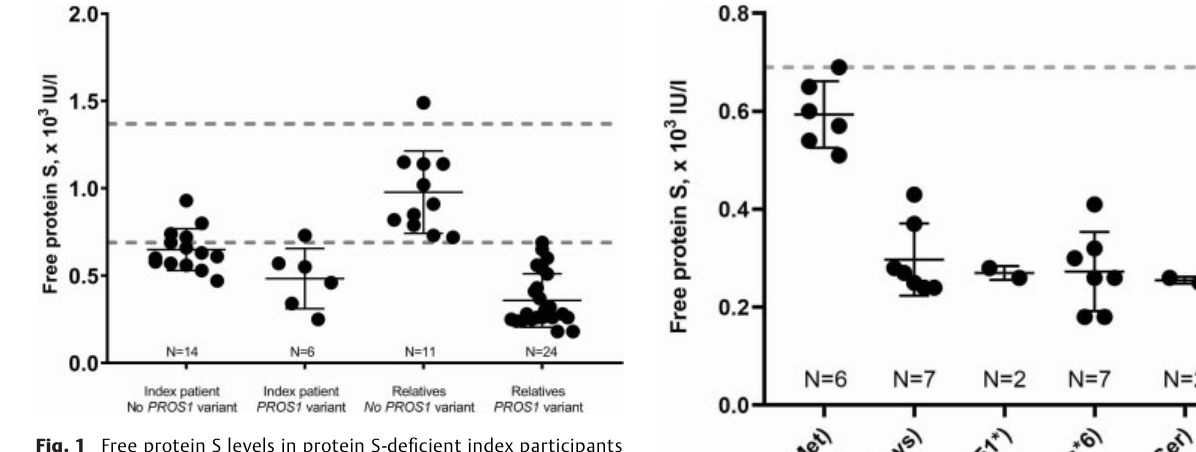
Fig. 1 Free protein S levels in protein S-de fi cient index participants witha PROS1 variantor withnormal PROS1 sequenceand relatives with PROS1 variant or normal PROS1 sequence. PROS1 variants included were: p.(Glu67Ala), p.(Thr78Met), p.(Gln305 (cid:4) ), p.(Thr331Ile), p. (Met385Val), p.(Glu390Lys), p.(Arg451 (cid:4) ), p.(Ile490Leufs (cid:4) 6), p. (Ser501Pro), p.(Leu526Ser). The reference interval for free protein S (0.69 – 1.37 (cid:1) 10 3 IU/L) is indicated by dotted horizontal lines . Fig. 2 Free protein S levels in protein S-de fi cient participants carrying fi ve speci fi c PROS1 variants. The lower reference limit for free protein S